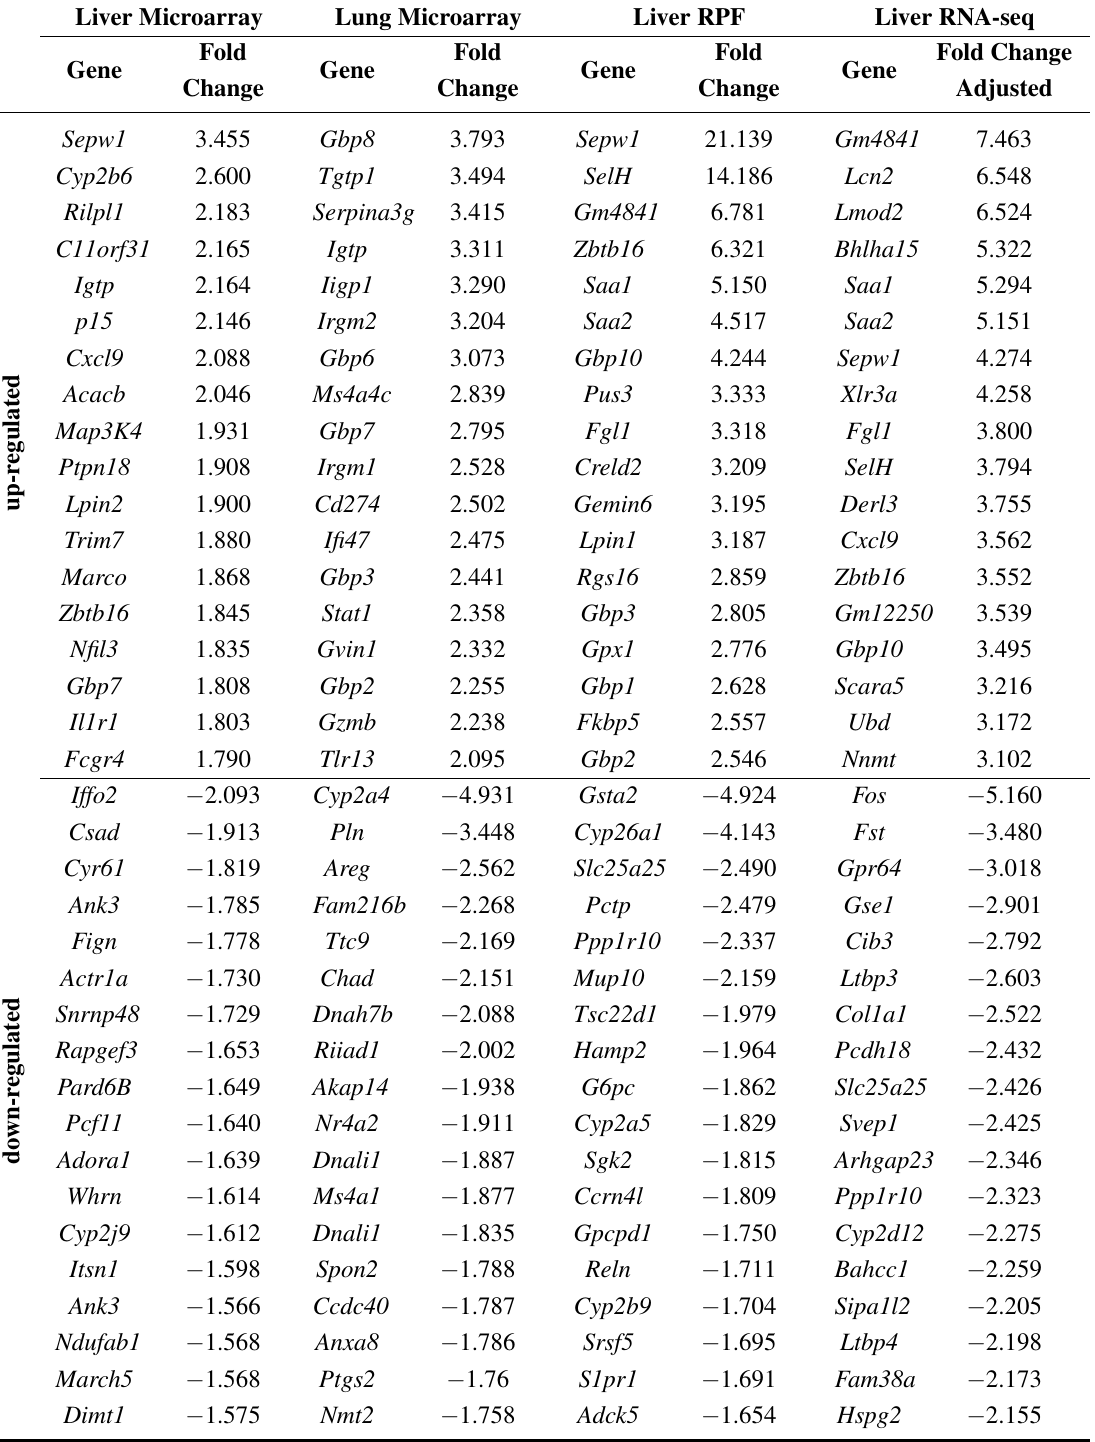
Table 1. Genes showing the largest fold change in mRNA levels or translation in mice fed diets supplemented with 0.1 ppm Se relative to mice fed 0 ppm Se